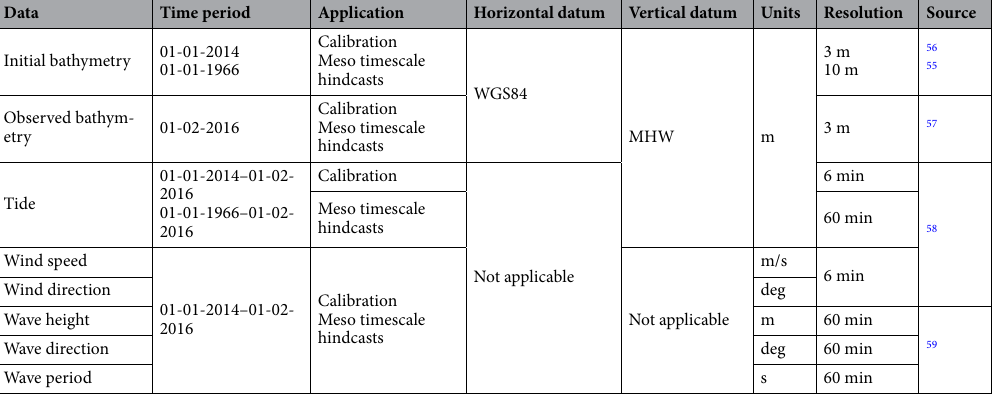
Table 2. Data for model calibration (2014–2016) and meso timescale hindcasts